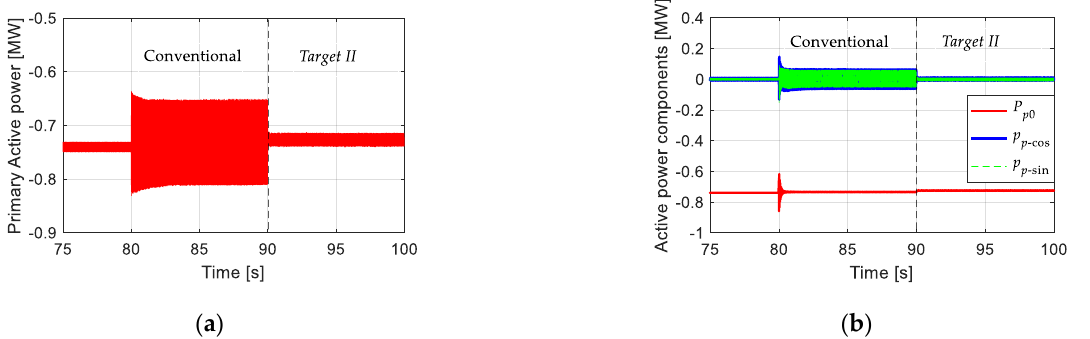
Figure 9. Comparative simulation results for 10% voltage unbalance occurring at 80 s with Target I ( a ) primary current; ( b ) positive components; ( c ) negative components.